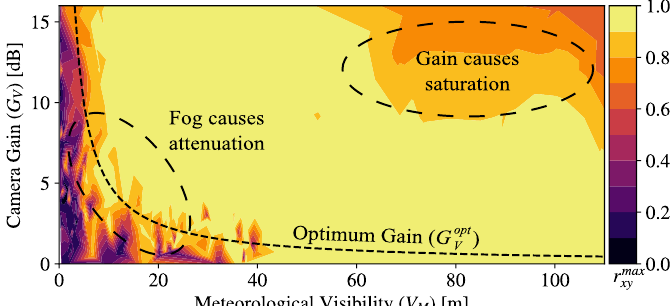
Figure 6. Maximum correlation between test and reference signals varying camera gain under emulated fog conditions of different values of meteorological visibility.